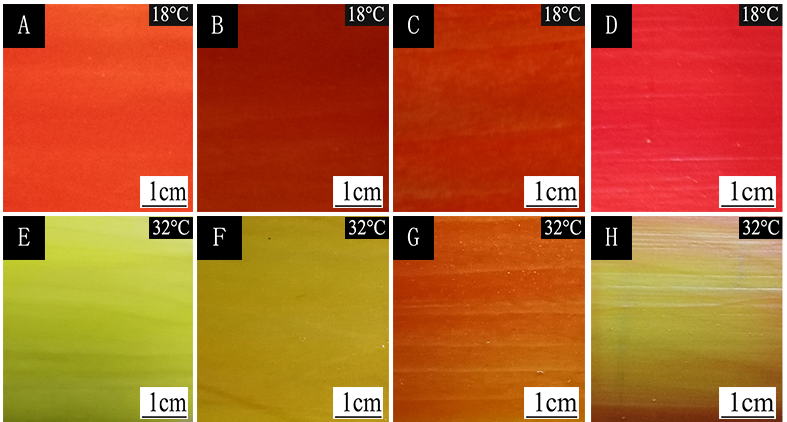
Figure 5. The influence of coating technologies on the color difference of waterborne coating from 18 to 40 ◦ C.